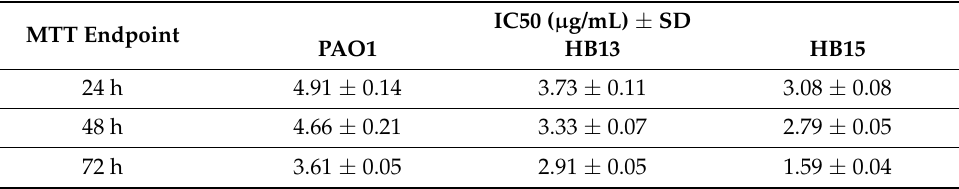
Table 1. Determined values of the IC50 ( µ g/mL). The A549 cells were screened for cytotoxicity at three MTT endpoints (24, 48, and 72 h) with the whole supernatant of a bacterial culture. All assays were repeated independently three times and each independent MTT assay included at least four technical replicates. Standard deviations (SD) are